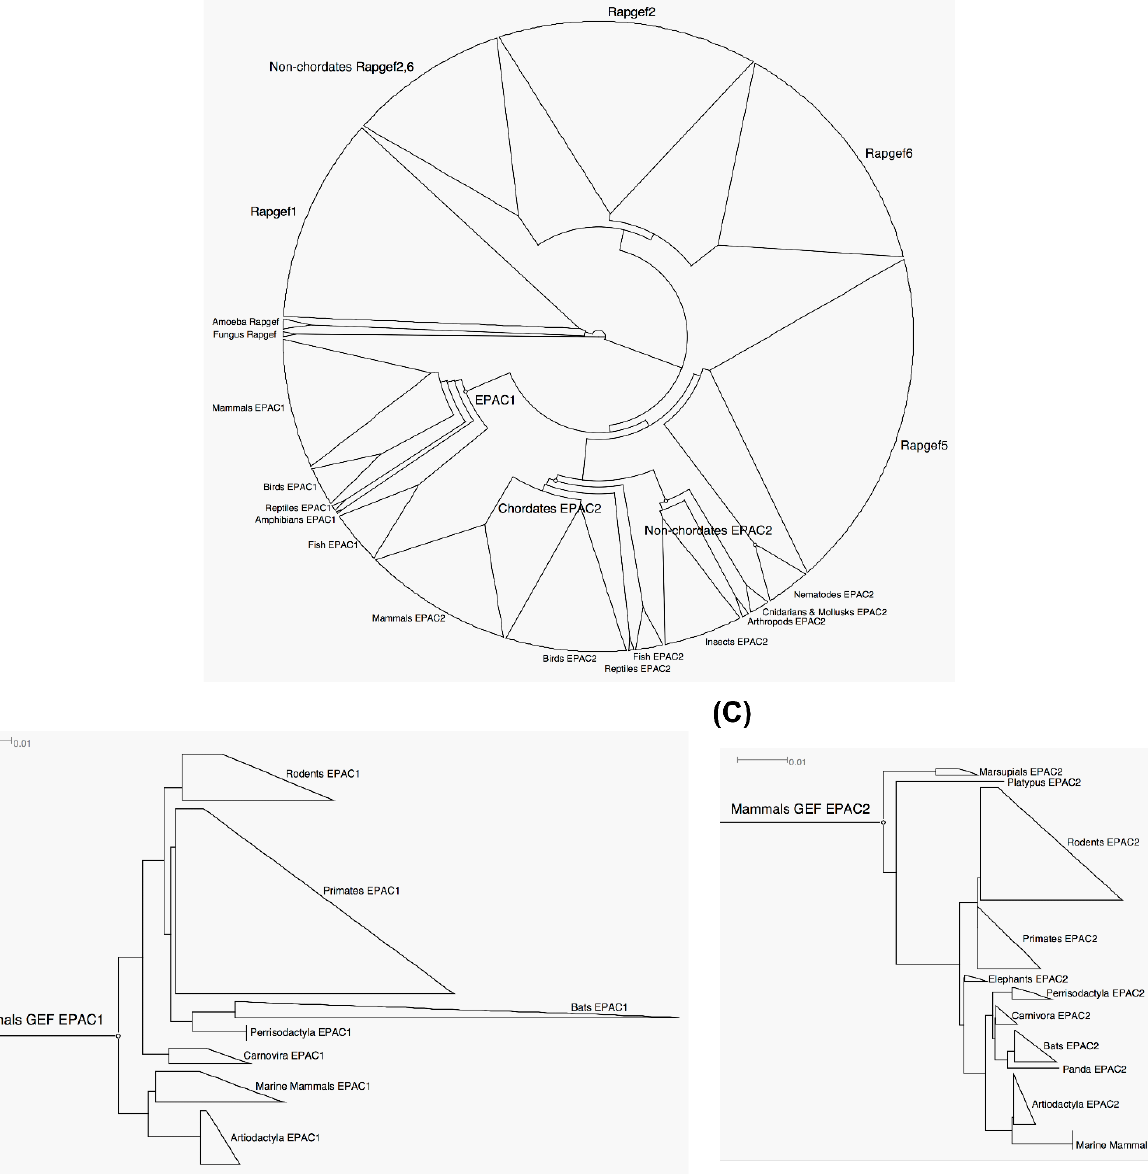
Figure 4. Phylogenetic analyses of the GEF of RAPGEF1-6. ( a ) Unrooted cladogram of the GEF of RAPGEF1-6. ( b ) Rooted phylogram of the mammalian GEF of EPAC1. ( c ) Rooted phylogram of the mammalian GEF of EPAC2. Scale bars: 0.01 represents 1 aa substitution per 100.